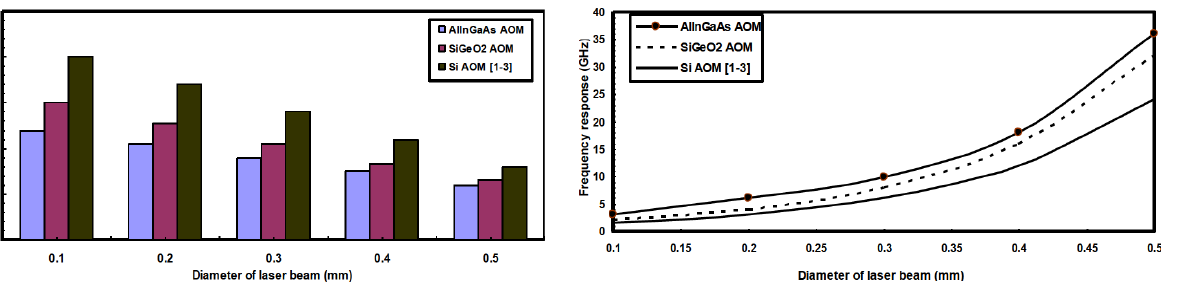
Figure4showsthevariationsinmodulationfrequency in relation to the laser beam diameter for both the previ-